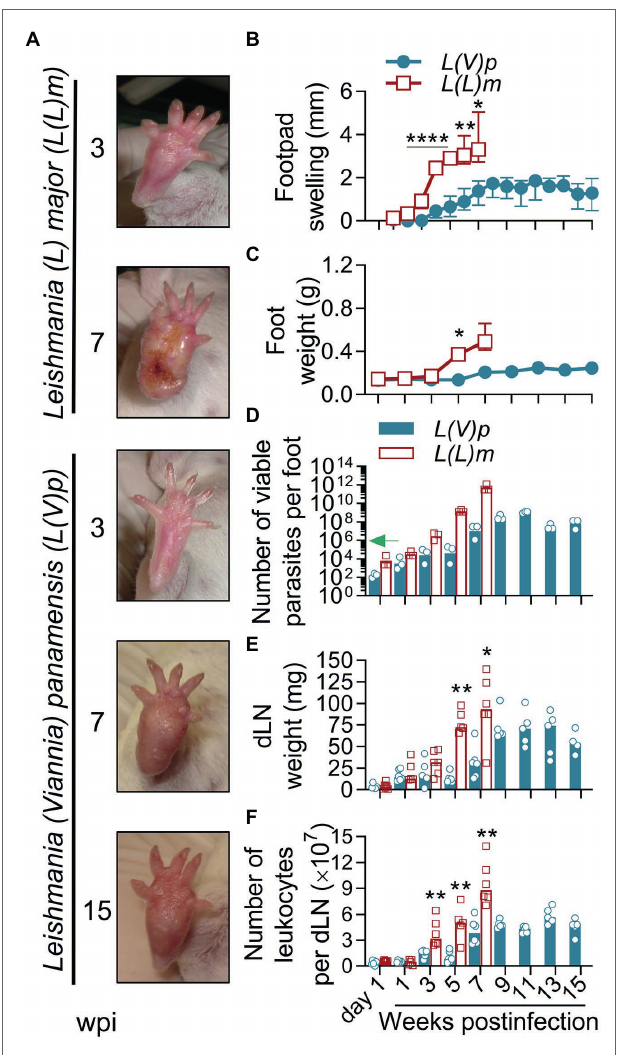
FIGURE 1 | Localized non-ulcerative chronic lesions in the footpads of mice infected with L(V)p . BALB/c mice were infected subcutaneously (sc) with 10 6 Leishmania (Viannia) panamensis ( L(V)p ) stationary promastigotes in the right footpad and monitored weekly. In parallel, a group of mice were infected with a similar inoculum of Leishmania (Leishmania) major ( L(L)m ) promastigotes as a control with a highly pathogenic Leishmania species in BALB/c mice. Representative photographs at the indicated time postinfection are presented (A) . The severity of lesions in mice infected with L(L)m at the 7th week postinfection obligated immediate euthanasia. Footpad swelling was individually measured and graphed (B) . At the indicated time, mice were sacrificed and the weight (C) and the number of viable parasites (D) of the foot determined. Draining lymph nodes (dLN) were also removed and the weight (E) and cellularity (F) determined. Results are expressed as the median ± interquartile range (B) , median ± range (C) , geometric mean (D) or median (E,F) from 2–7 mice per time/group. The arrow in (D) indicates the infective inoculum. wpi, weeks postinfection. * p < 0.05, ** p < 0.01, and **** p < 0.0001 [mixed-effects analysis (B) ; two-way ANOVA (C) with Geisser– Greenhouse correction and Bonferroni’s multiple comparisons post-hoc test for multiple comparison through time; Mann–Whitney U -test (E,F)